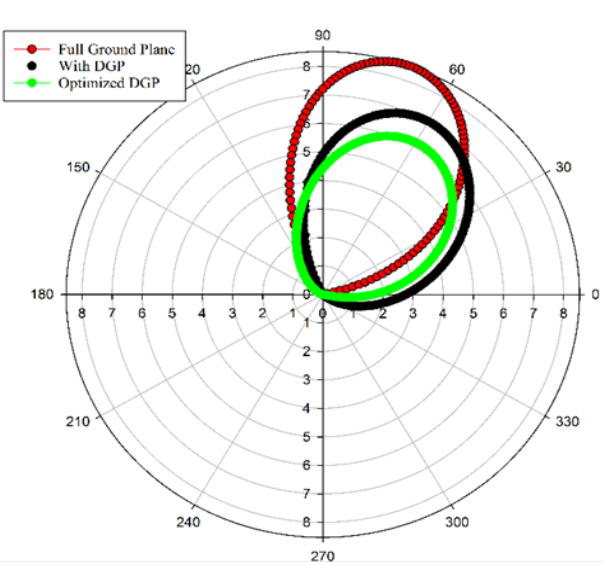
Micromachines 2023 , 14 , x FOR PEER REVIEW Figure 2. Ground plane optimization step: ( a ) full ground plane ; ( b ) DGP ; and ( c ) optimized DGP. Figure 2. Ground plane optimization step: ( a ) full ground plane; ( b ) DGP; and ( c ) optimized DGP.